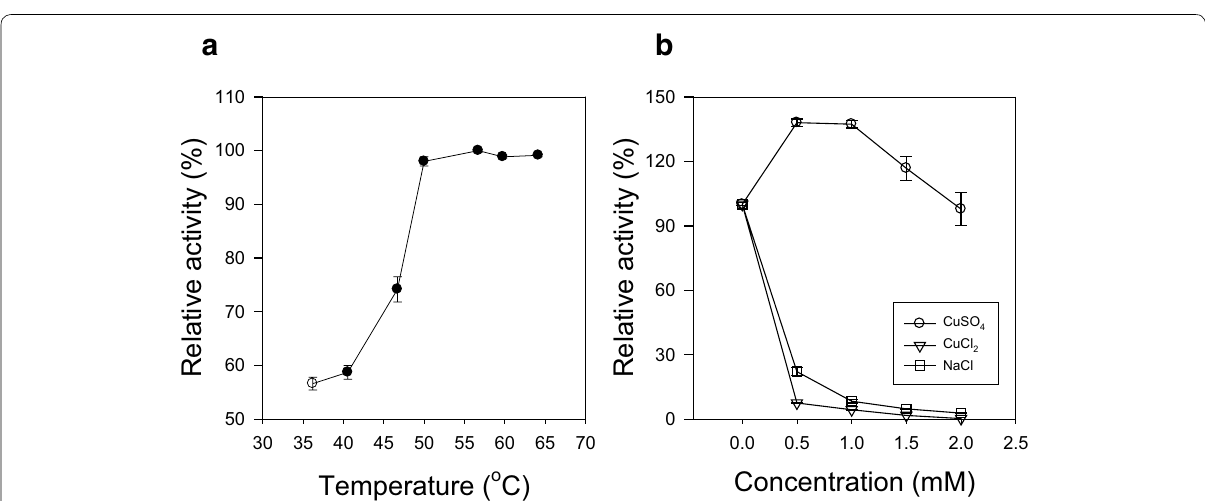
Fig. 4 Characterization of recombinant crude LacB. a Effect of incubation temperature on MCO activity. b Effect of metal ion addition on MCO